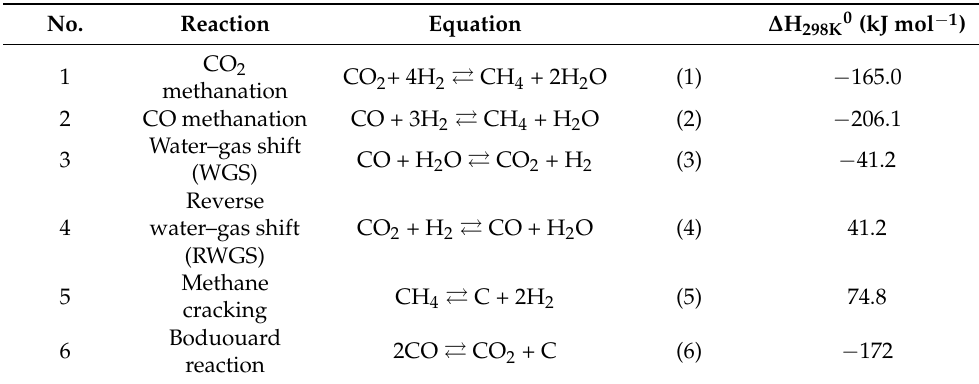
Table 1. Reactions involved in CO 2 hydrogenation